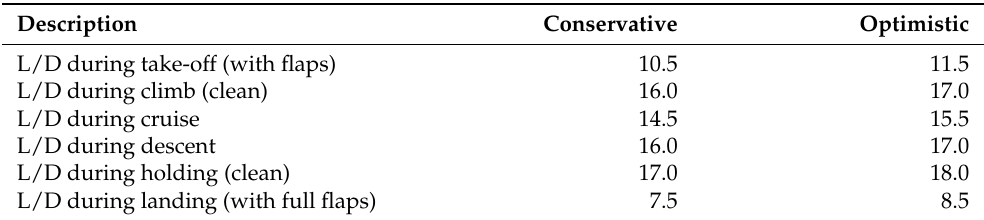
Table 3. Basic aerodynamic assumptions on the glide ratio of a conventional regional aircraft during various flight